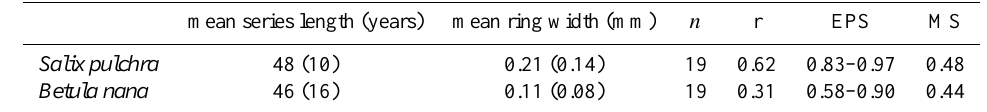
Table 1. Statistics of Salix pulchra and Betula nana ring-width residual